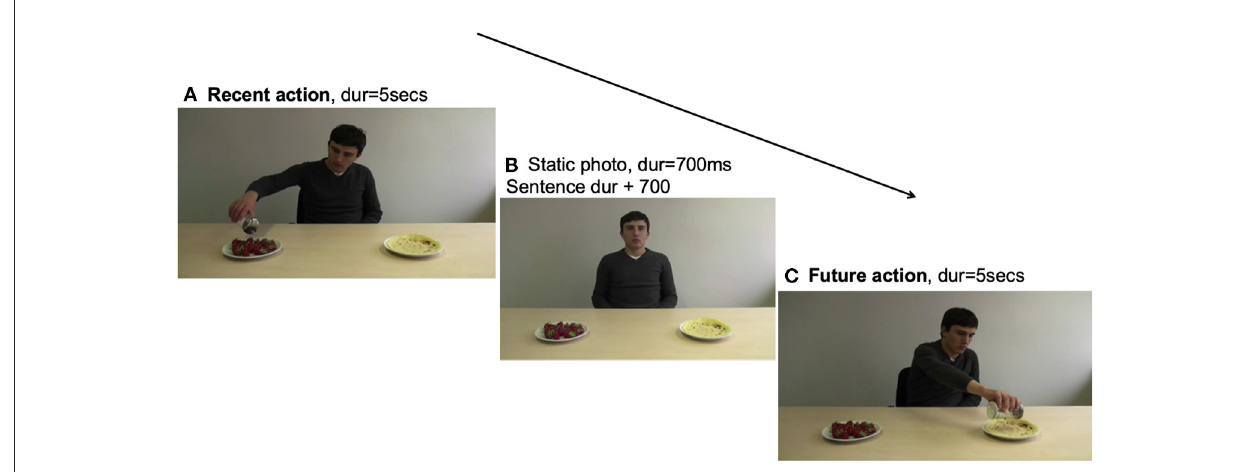
FIGURE1 An example of the order of presentation of the visual stimuli in a typical experimental trial. (A) Recent action (duration = 5 s). (B) Static photo (duration = 700 ms) sentence duration + 700 ms. (C) Future action (duration = 5 s).